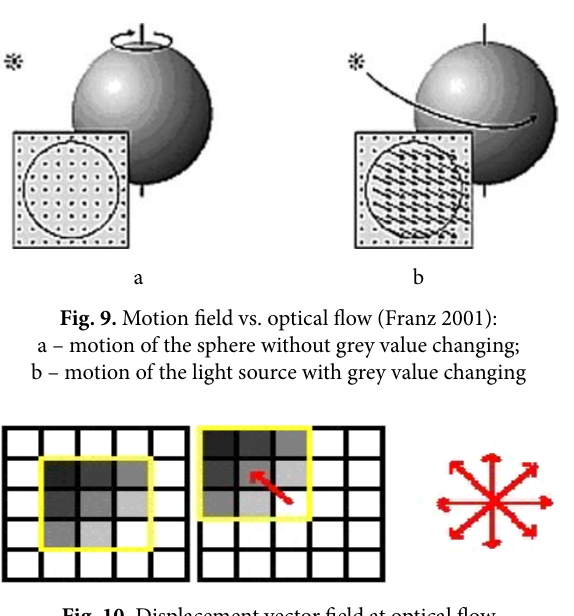
Fig. 10. Displacement vector field at optical flow